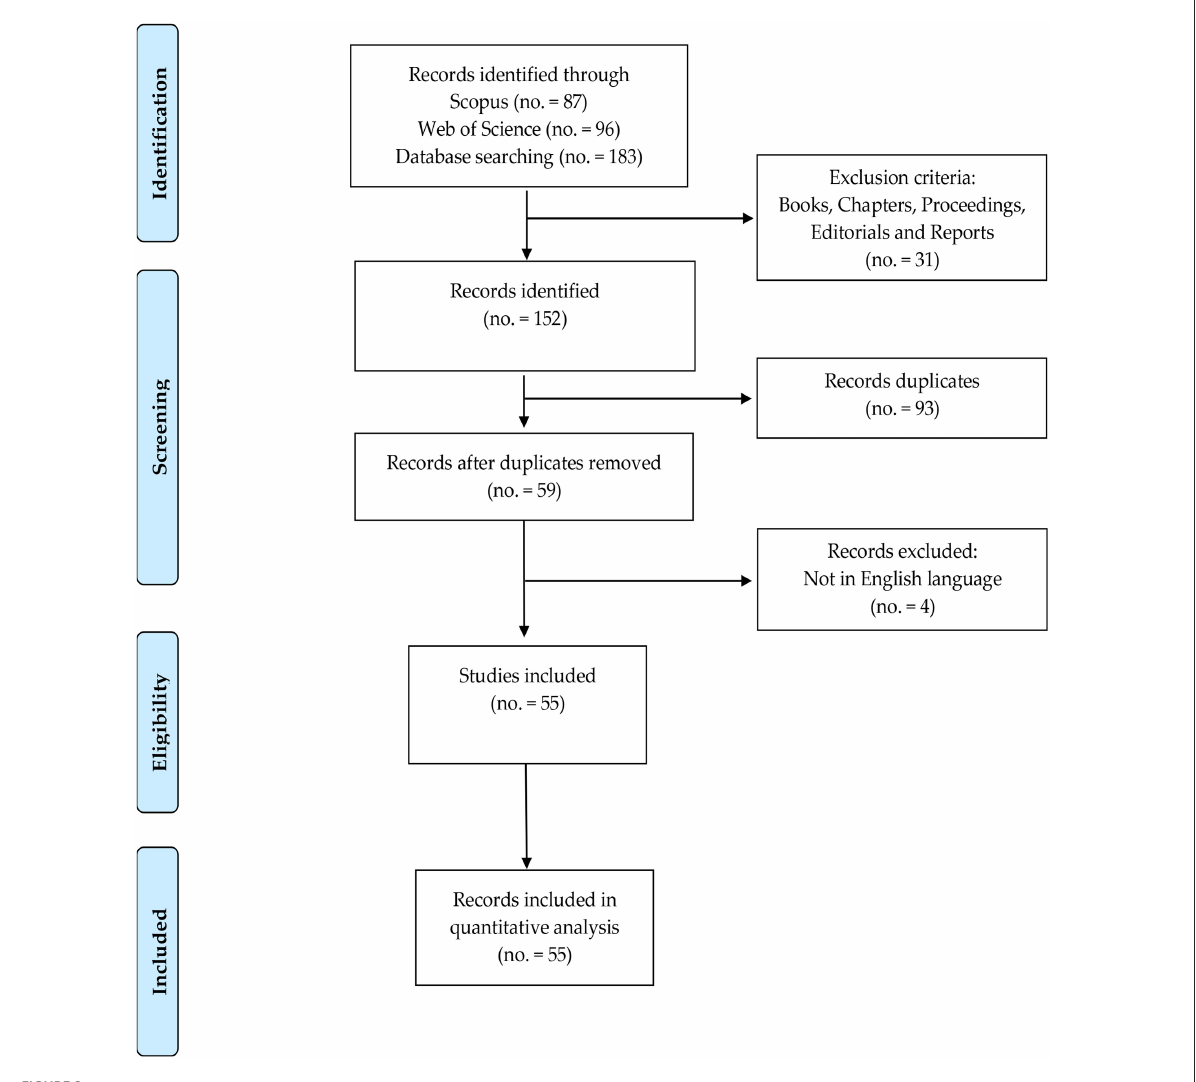
FIGURE2 Flowchart of the database literature research. Source: our